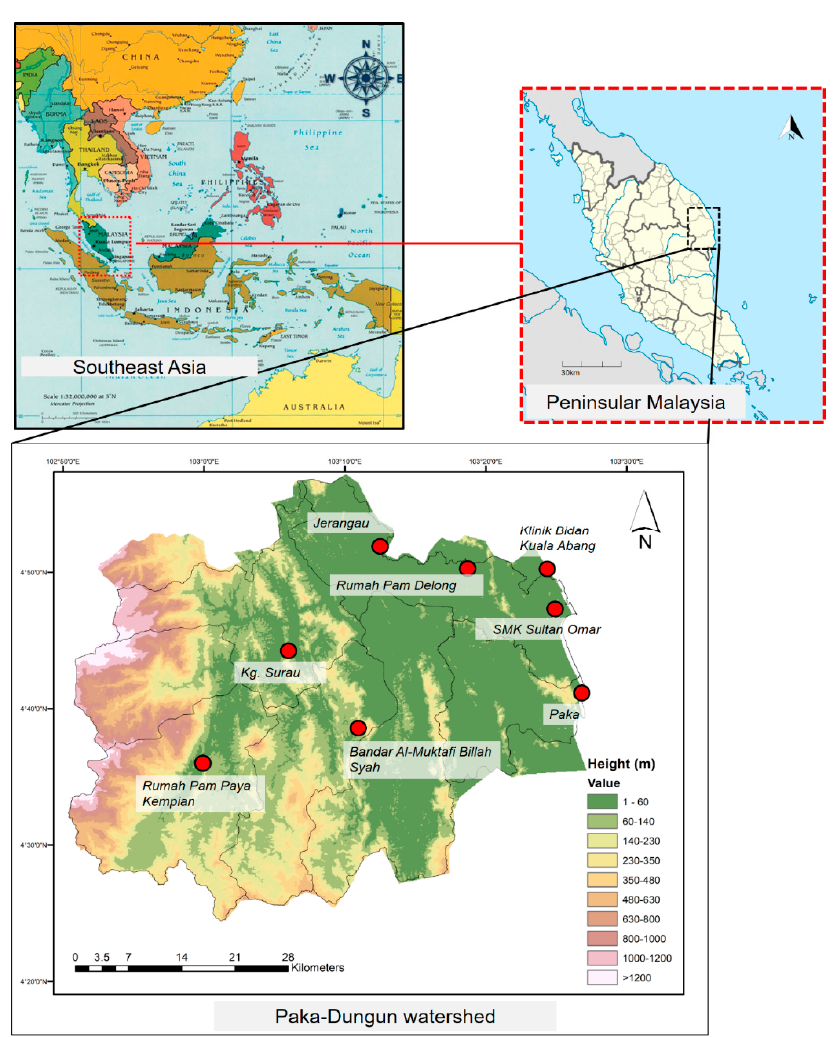
Figure 1. Study area. The red dots are the locations of the rain gauges.